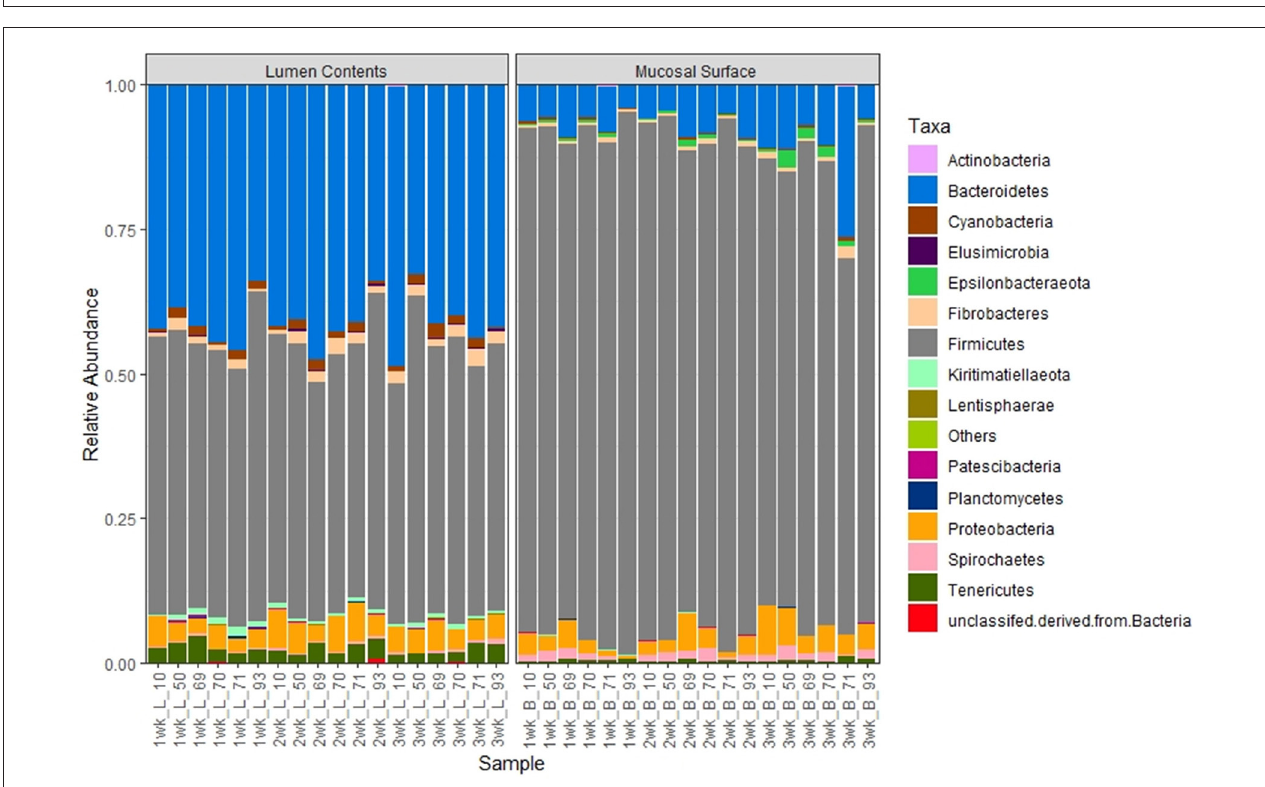
FIGURE 6 | Bacterial phylum. Stacked bar chart representing the abundance of the microbiota at the phylum taxonomic level in the mucosal biopsy surface and lumen contents across the sampled weeks for each animal.